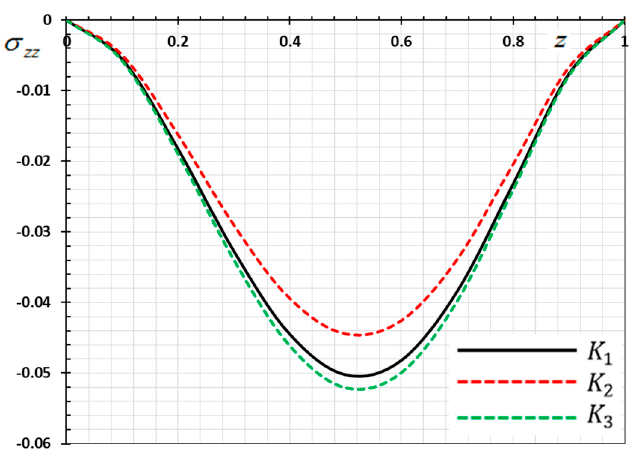
Figure 3. Variation of thermal stress σ zz versus z for di ff erent forms of kernel function k ( t − ξ )